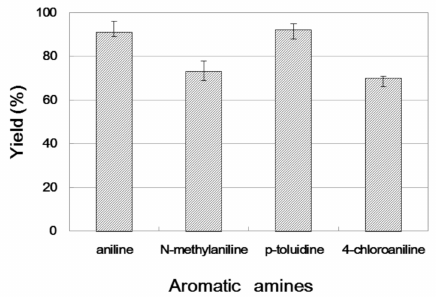
Figure 6. The influence of substrate structure on the enzymatic synthesis of β -amino alcohol 3a under continuous-flow conditions.